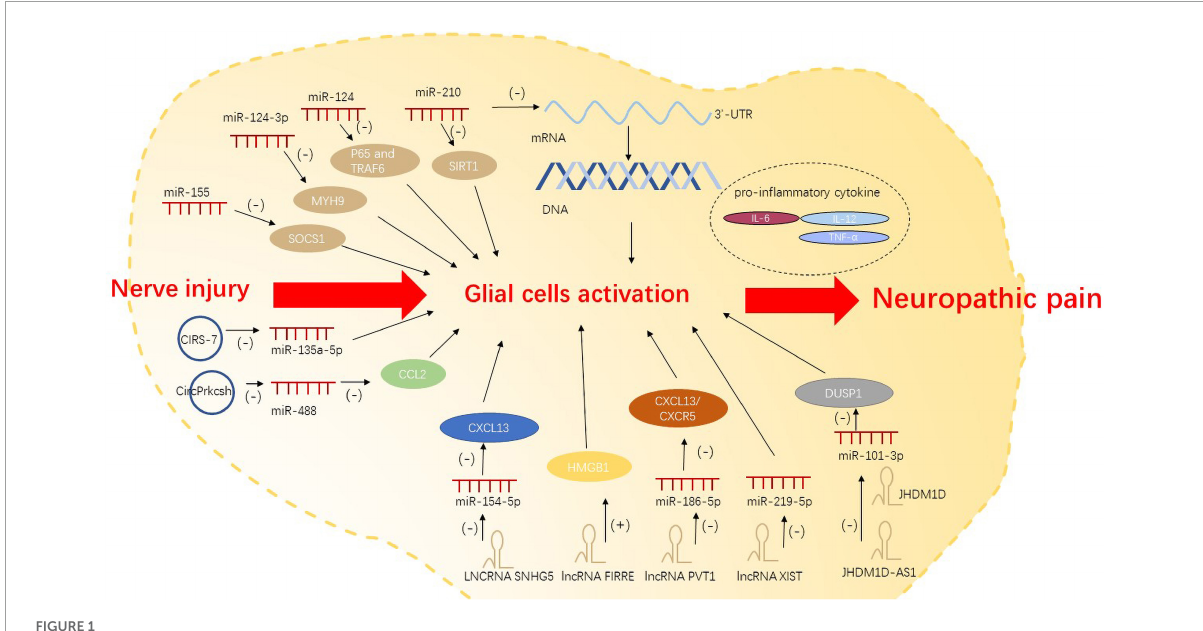
FIGURE1 Non-coding RNAs regulate neuropathic pain via glial cell